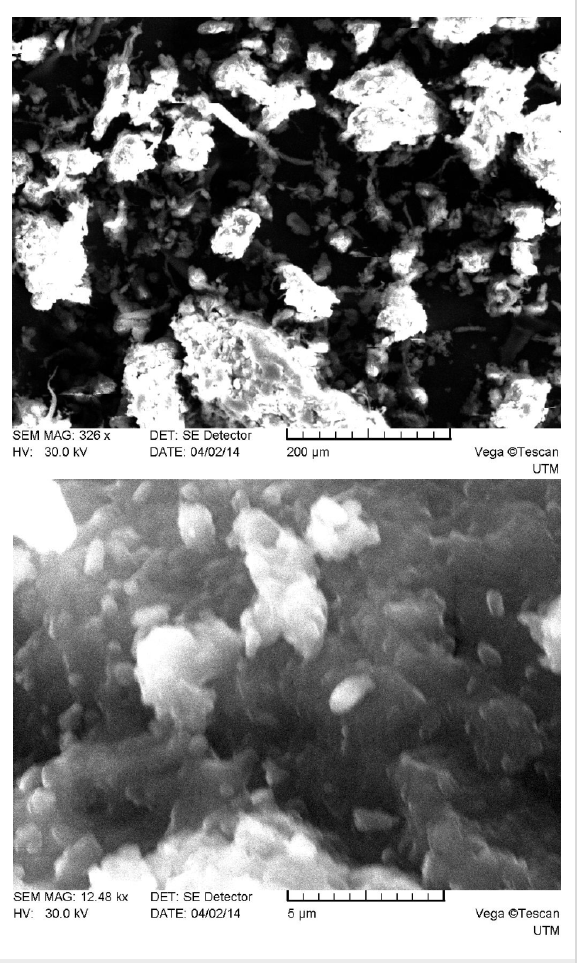
Figure 6: SEM micrographs of system 5 particles (top: magnification 333×, bottom: 9330×).